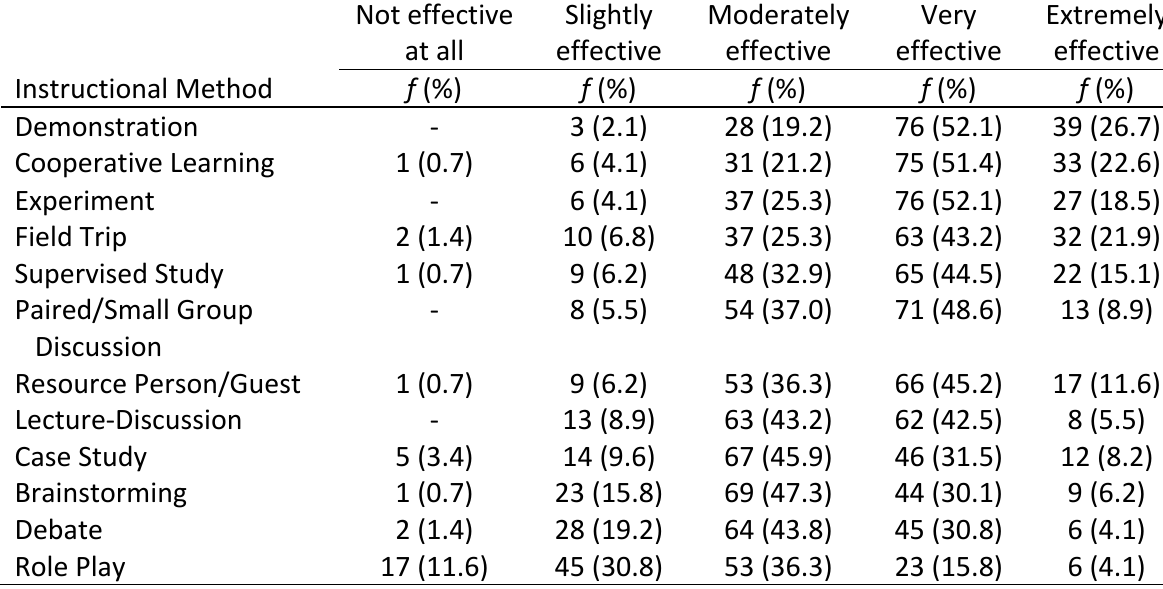
Frequency of Teachers’ Belief of Effectiveness by Instructional